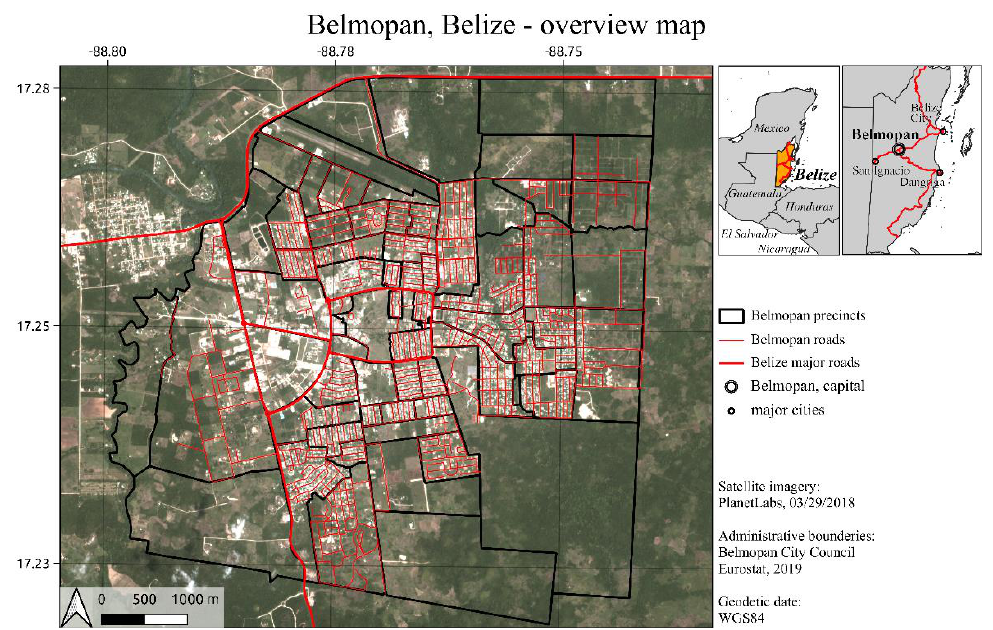
Figure 1. General map of Belmopan and its regional geographical situation.